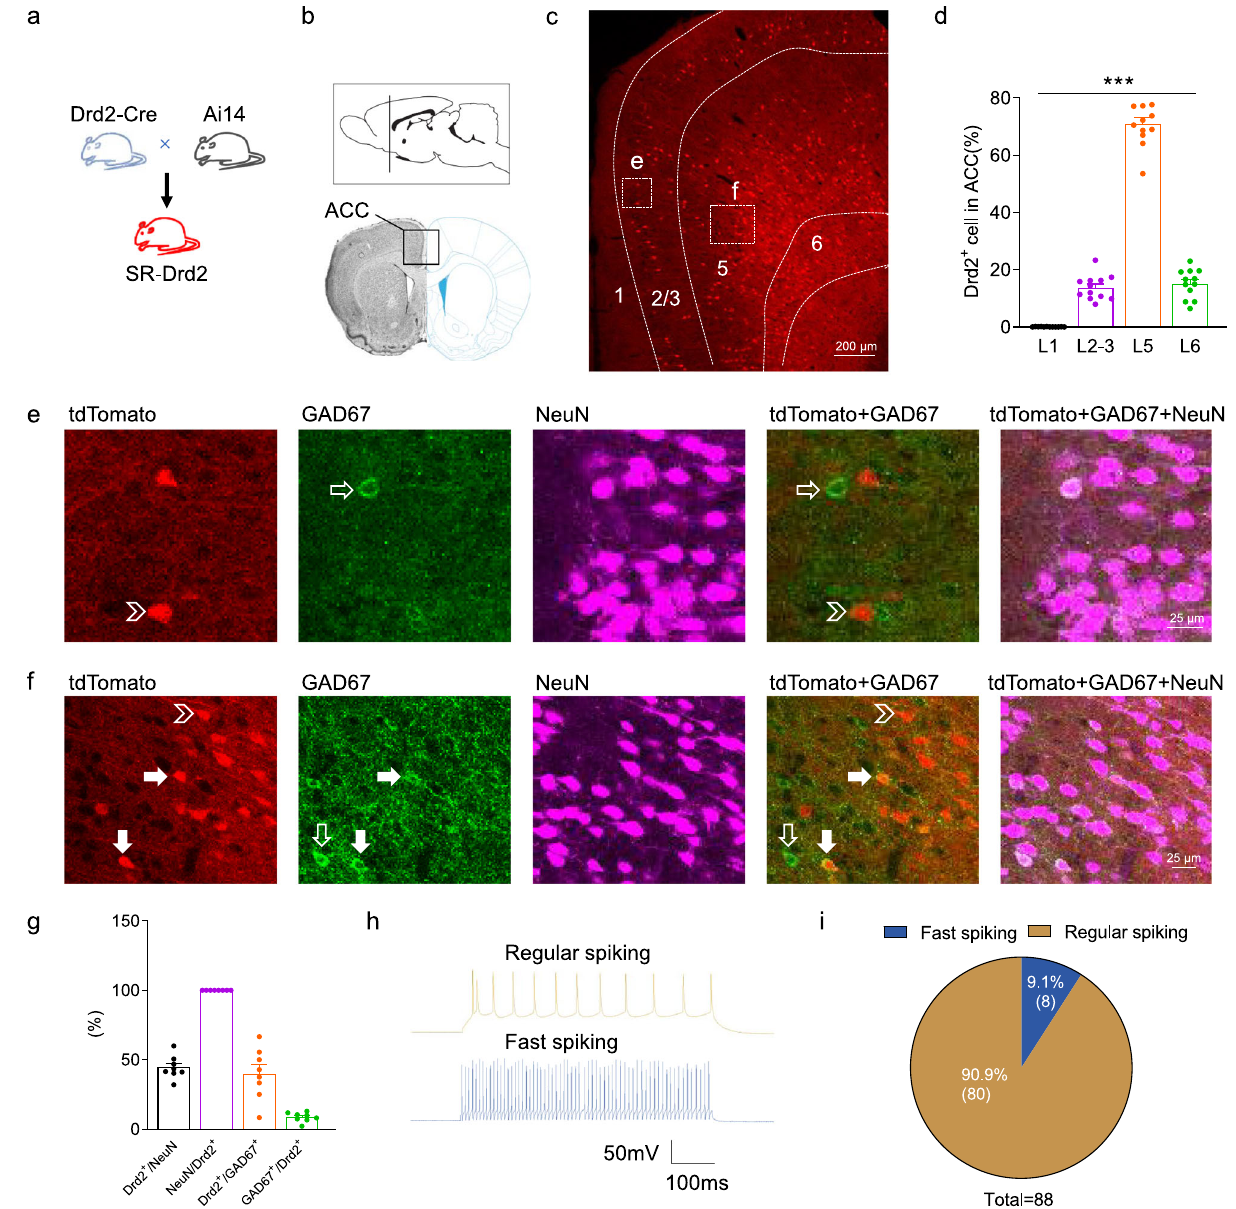
Fig. 1 Cellular expression pattern of Drd2 in rat ACC. a Generation of SR-Drd2 rats by crossing heterozygous Drd2-Cre rats with heterozygous Ai14 (Rosa26-LSL-tdTomato) rats. b Diagram of rat brain sagittal section (top) and coronal section (bottom). The dashed line of the sagittal section diagram indicates the position of the coronal section. The rectangle indicates the brain regions of ACC. c Expression of tdTomato in the ACC from SR-Drd2 rats. Scale bar, 200 μ m. d The percentage of Drd2-positive cells in different layers of ACC among total Drd2-positive cells in ACC. *** P < 0.0001, one-way ANOVA, n = 12, Data are presented as mean values± SEM. e, f Immuno fl uorescent images of tdTomato, GAD67, and NeuN from the rectangles in panel c . Arrowheads indicate Drd2-positive but Gad67-negative cells, empty arrows indicate Gad67-positive but Drd2-negative cells, solid arrows indicate Drd2- positive and Gad67-positive cells. Scale bar, 25 μ m. g The percentage of neurons expressing Drd2 (Drd2 + /NeuN = 44.47%). All Drd2-positive cells are neurons (NeuN/Drd2 + = 100%). The percentage of GABAergic interneurons expressing Drd2 (Drd2 + /Gad67 + = 39.91%). The percentage of Drd2- positive neurons that were GABAergic interneurons (Gad67 + / Drd2 + = 8.693%). n = 8, Data are presented as mean values ± SEM. h Representative action potentials of regular spiking and fast-spiking neurons. i 90.9% of Drd2 + neurons are regular spiking neurons. n = 88 neurons from 10 SR-Drd2 spines. Here we focused on the secondary basal dendrites (Fig. 2e) The spine densities of Drd2-positive neurons from 2 to 4-week- where the majority of spines are formed on the layer 5 pyramidal old age were similar between control and SR-Drd2 + / − rats (Fig. 2f – h), which suggest that Drd2 + / − mutation may not affect neurons in cortex 40 . The spine densities of Drd2-positive neurons increased from 2 to 4-week-old age and then reduced toward 8- synapse formation. However, the spine densities of Drd2-positive week-old age in control rats (Fig. 2f – h). These results indicate a neurons were not reduced from 4- to 8-week-old age in SR- synapse formation during early postnatal period followed by a net Drd2 + / − rats (Fig. 2f – h), which indicate that Drd2 + / − mutation may impair synaptic pruning. The de fi cits of synaptic pruning synaptic pruning during adolescence in Drd2-positive neurons.